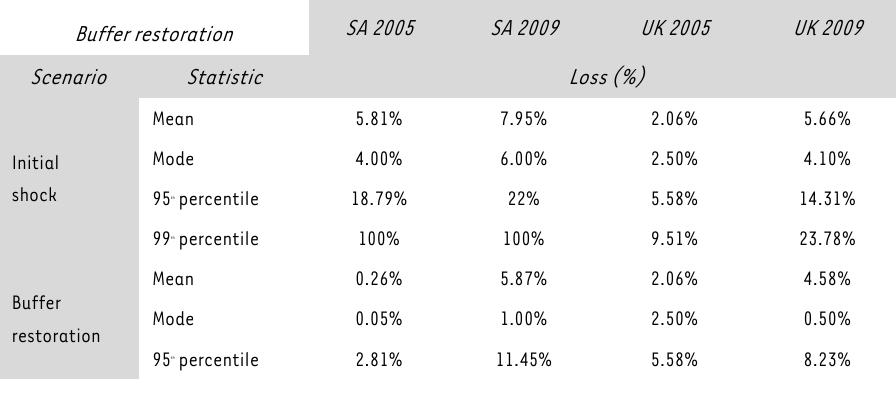
Loss statistics for increased market stress for both economies in both periods Buffer